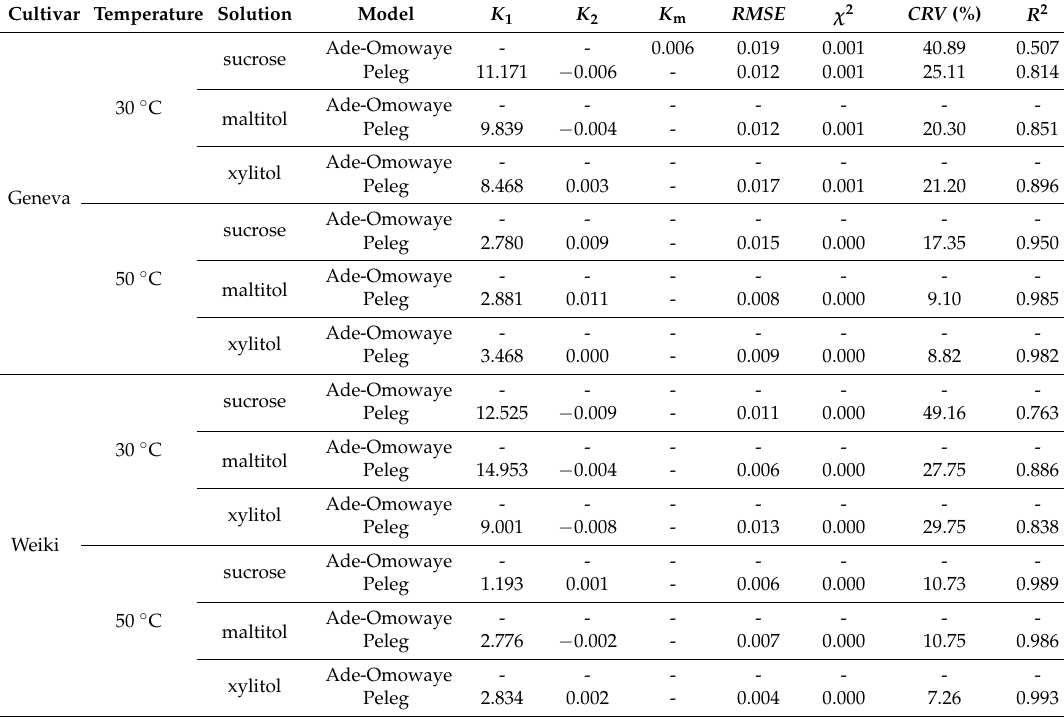
Table 3. Values of RMSE , χ 2 , R 2 and CRV of best fitting mathematical model of WR.